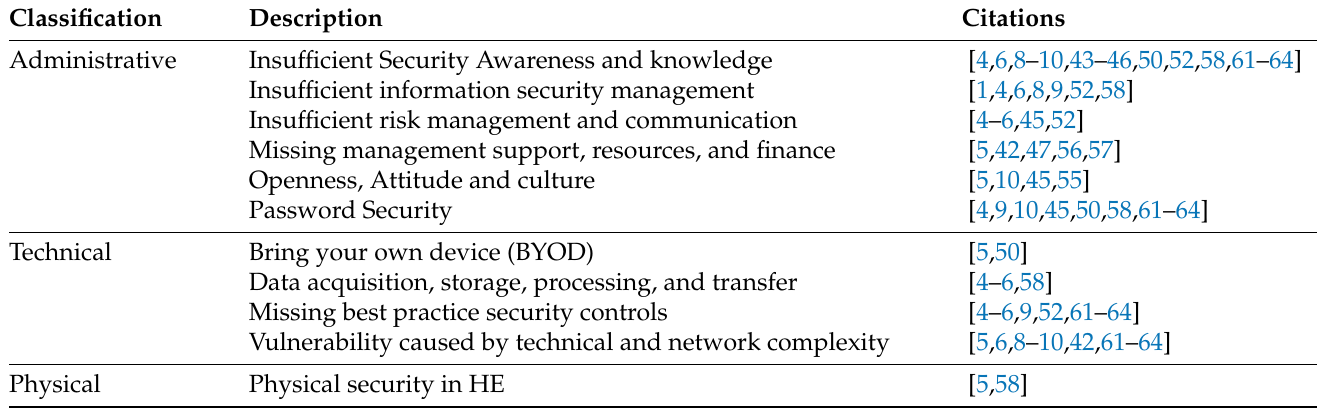
Table 14. Summary over vulnerability classifications, descriptions, and